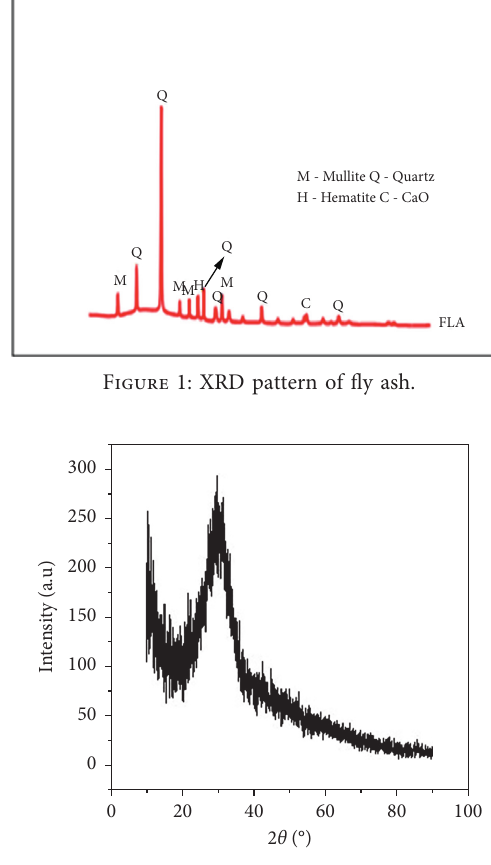
Figure 2: XRD pattern of GGBS.